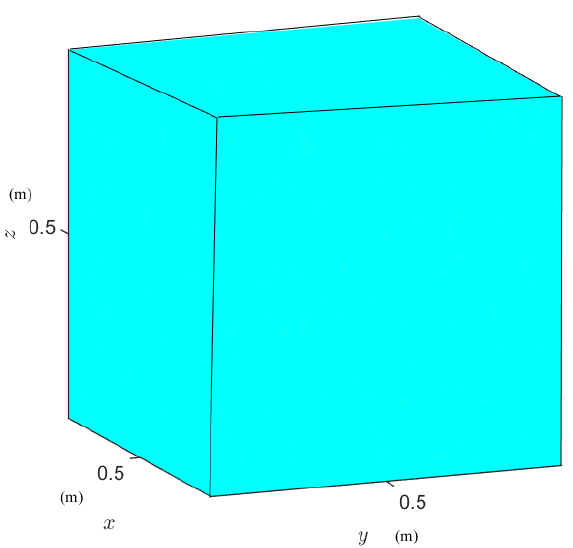
Figure 13. Computational domain.